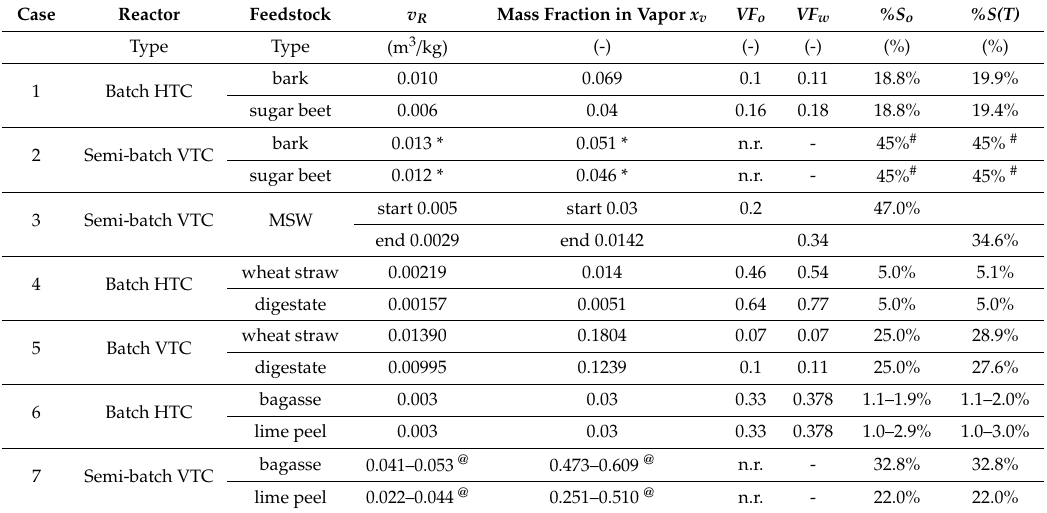
Table 3. Overview of process conditions and water distribution for the seven cases of VTC /